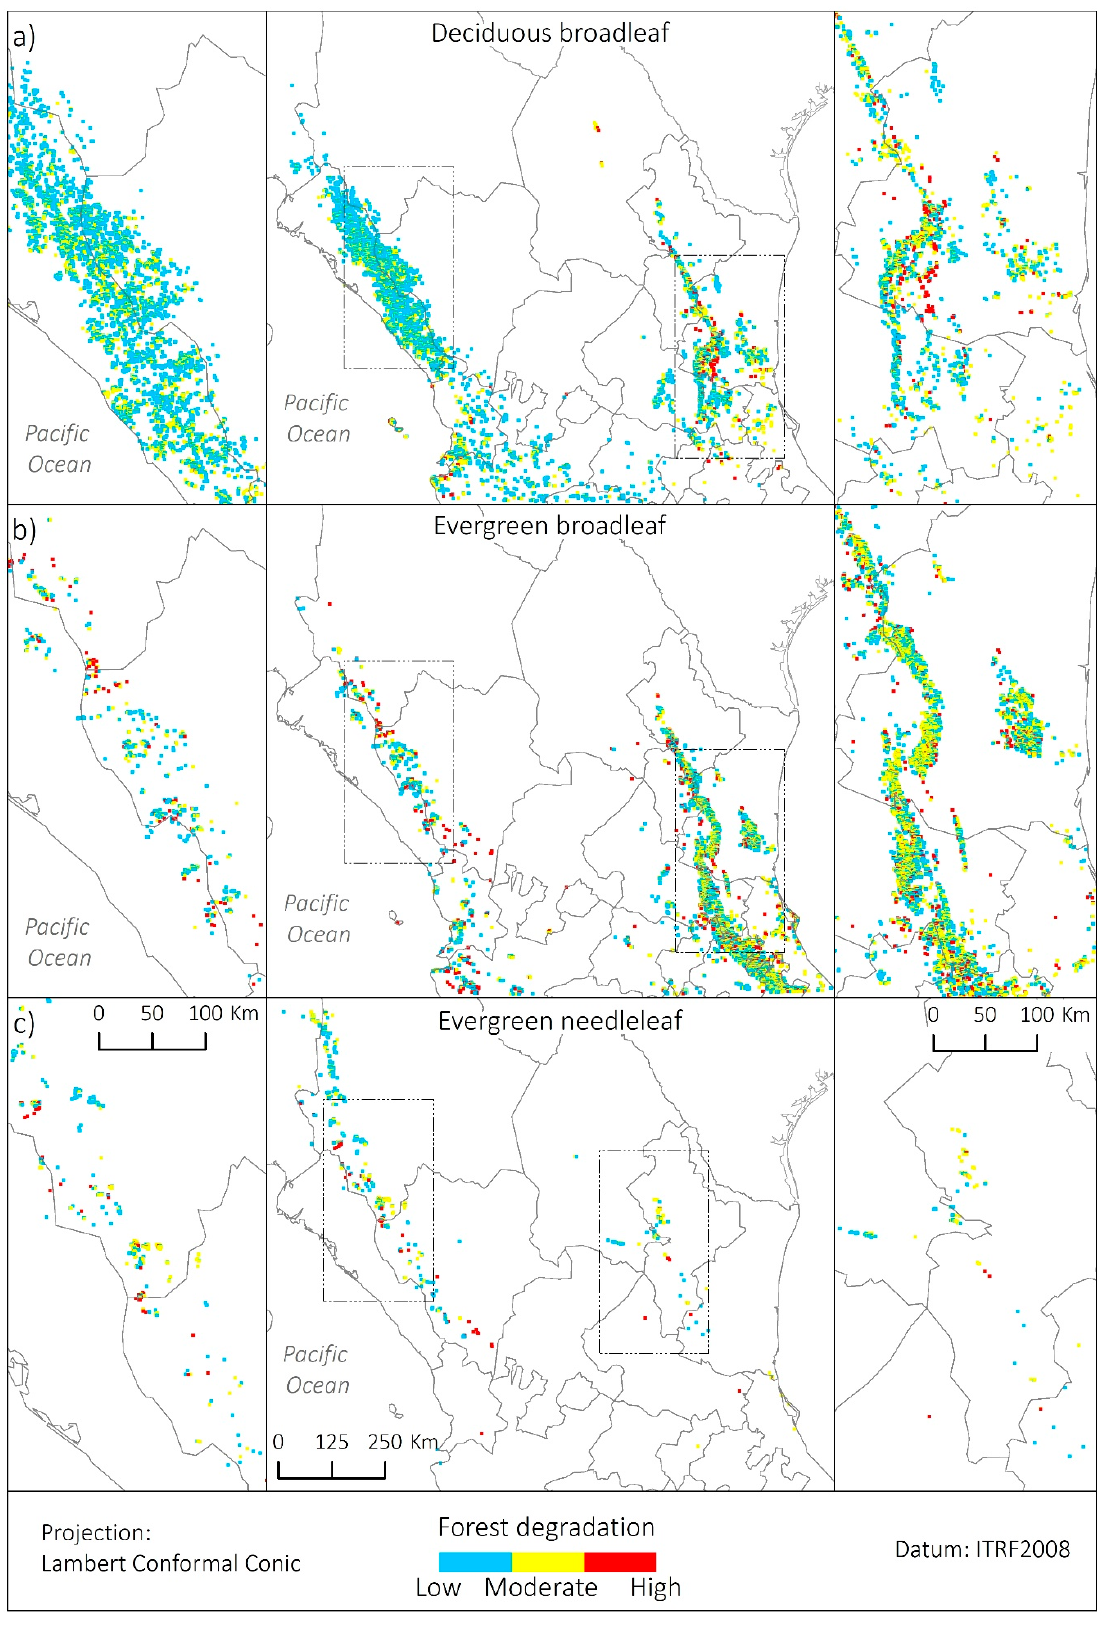
Figure 7. Degradation of deciduous broadleaf forest ( a ), evergreen broadleaf forest ( b ), and evergreen needleleaf forest ( c ) based on the strength and magnitude of negative trends at 95% confidence level, 2002–2017. *The pixel size has been exaggerated for visualization proposes.